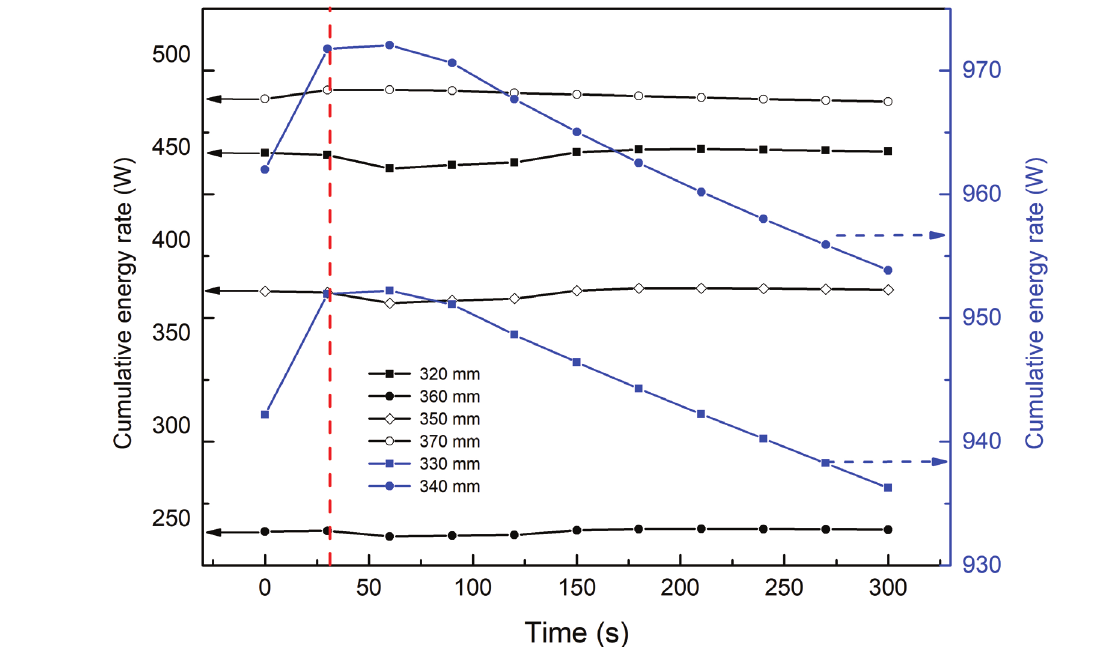
Figure 7: Global total cumulative energy rate (W), height range from 320 to 370